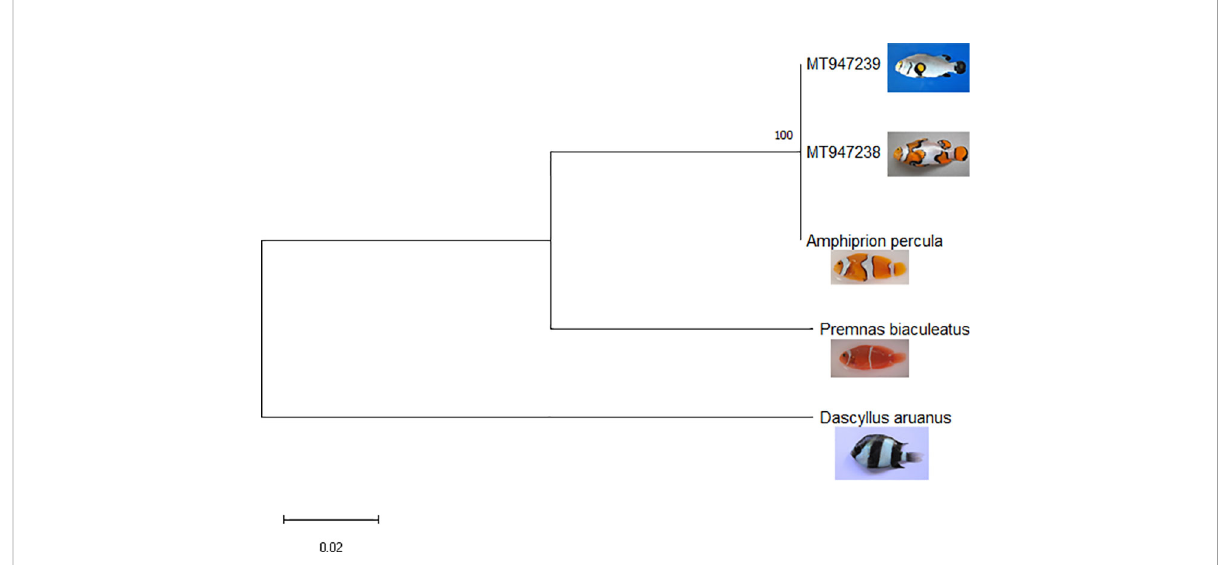
FIGURE 11 Maximum likelihood phylogenetic tree constructed using cytochrome c -oxidase subunit I (COI) sequences of designer clown fi